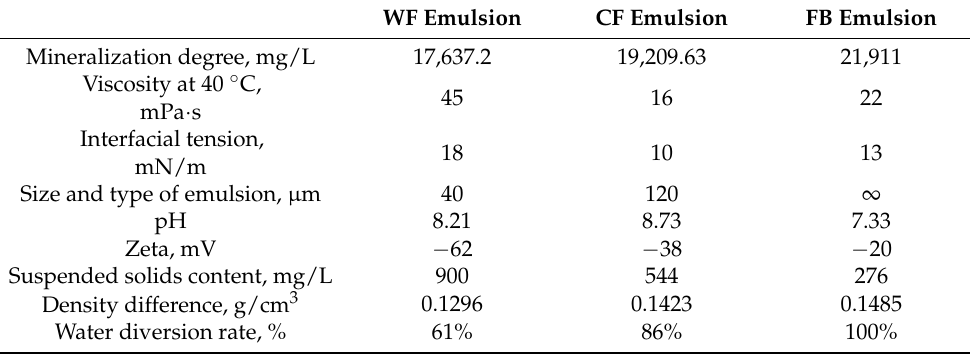
Table 3. WF, CF, and FB emulsion performance